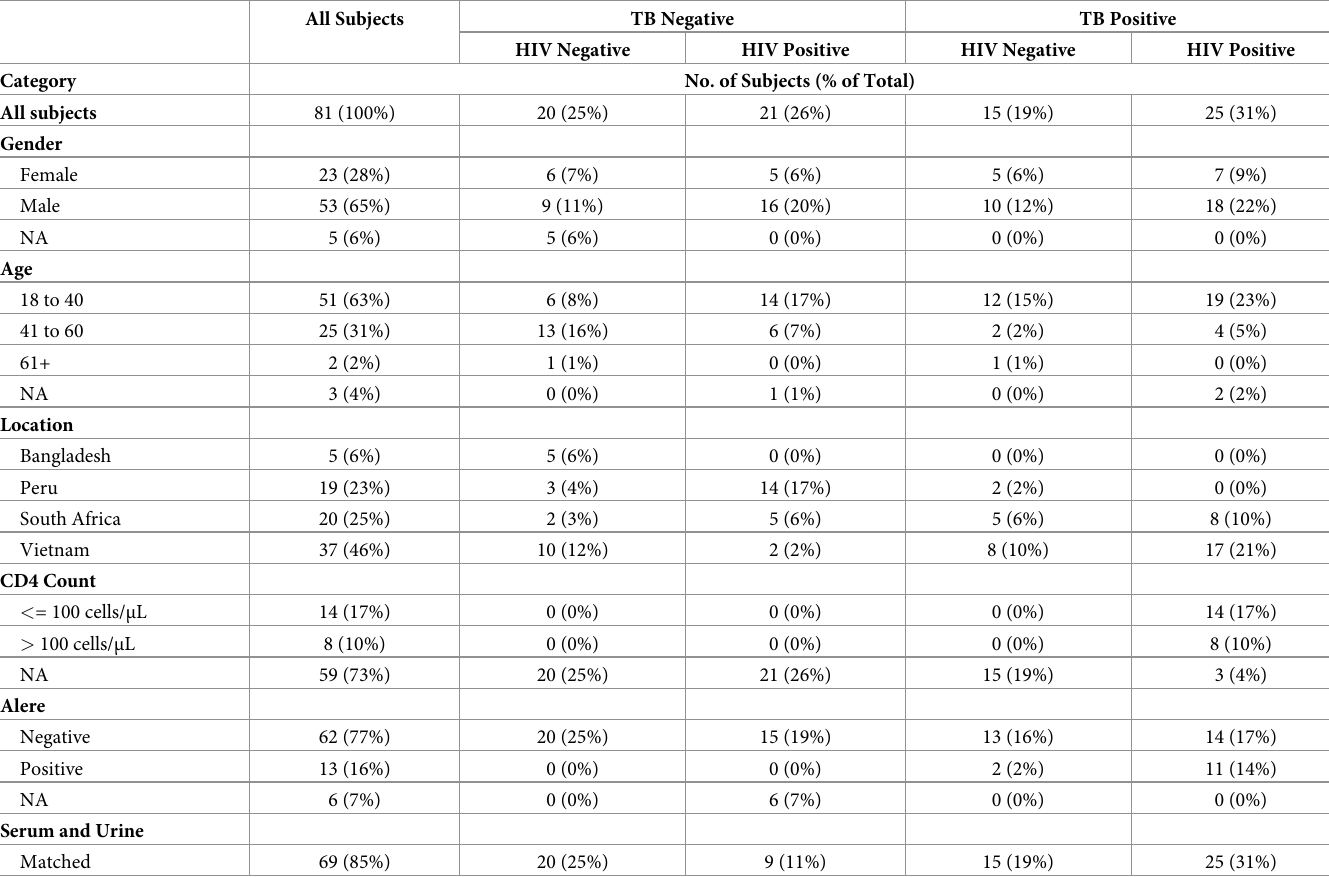
Table 1. Characteristics of the study population broken down by TB and HIV status. NA indicates that information for the specified characteristic was not available for a study subject. CD4 cell counts were only available for TB/HIV+ subjects. Alere LF-LAM results were only available for subjects with urine samples. Matched urine and serum samples were available for 69 of the 81 subjects. The remaining 12 subjects consisted of 6 TB+/HIV- subjects with only urine samples and 6 TB+/HIV- subjects with only serum samples. All